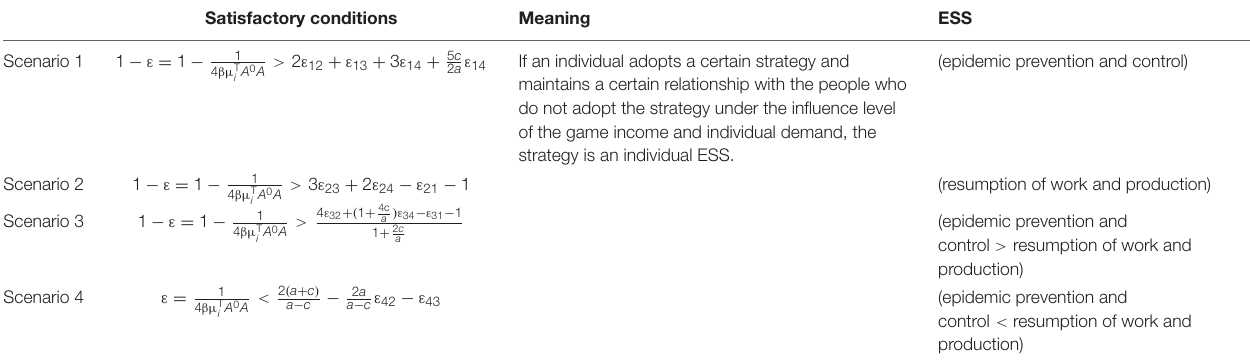
TABLE 5 | Individual game results. Satisfactory conditions Meaning ESS Scenario